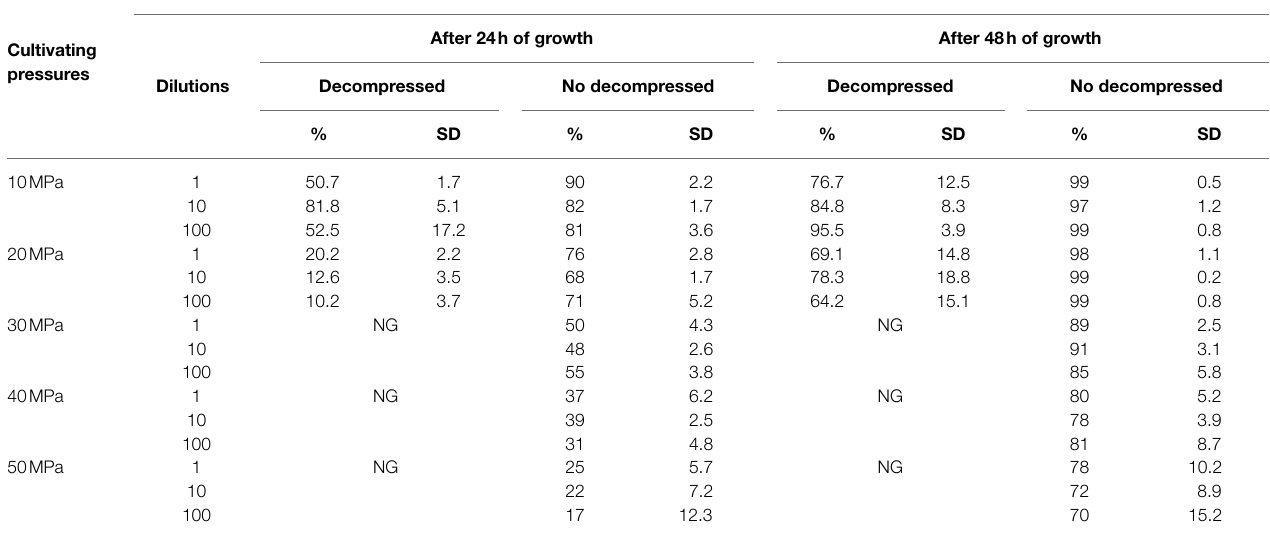
Percentage of growth recovery after transfer at ambient